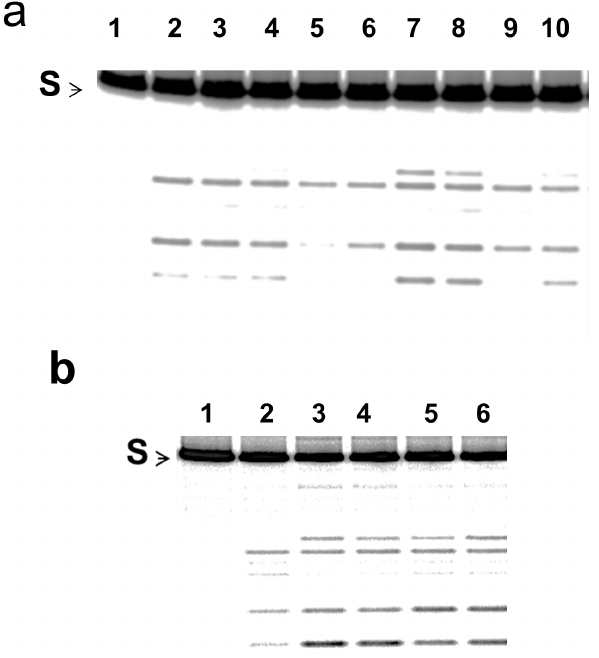
Figure 3. Effect of lichen Hypotrachynasp . HP20ss fractions and anziaic acid on cleavage product accumulation by E. coli topoisomerase I. Single-stranded DNA substrate labeled at the 5 9 - end with 32 P (S) was incubated with enzyme in the presence of 2 mM MgCl 2 . No enzyme (lane 1), enzyme with DMSO (lane 2). a. Unfractionated total extract (lanes 3, 4), fraction 3 (lanes 5, 6), fraction 4 (lanes 7, 8), fraction 5 (lanes 9, 10) with the extract or fraction compounds present at 3.1 m g/mL (lanes 3, 5, 7, 9) or 12.5 m g/mL (lanes 4, 6, 8, 10). b. Anziaic acid was present at 0.9 m M (lanes 3), 1.8 m M (lanes 4), 3.7 m M (lanes 5) and 7.2 m M (lanes 6).